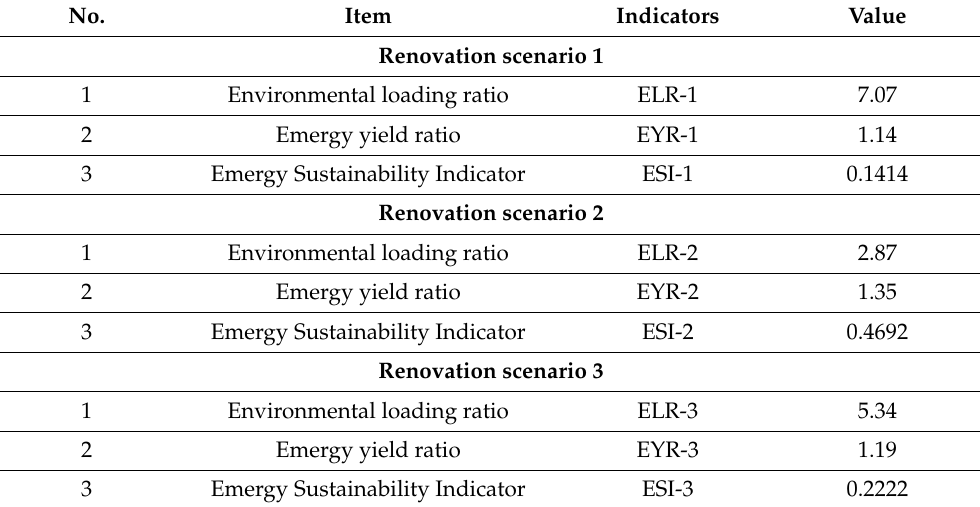
Table 8. Sustainability indexes of renovation